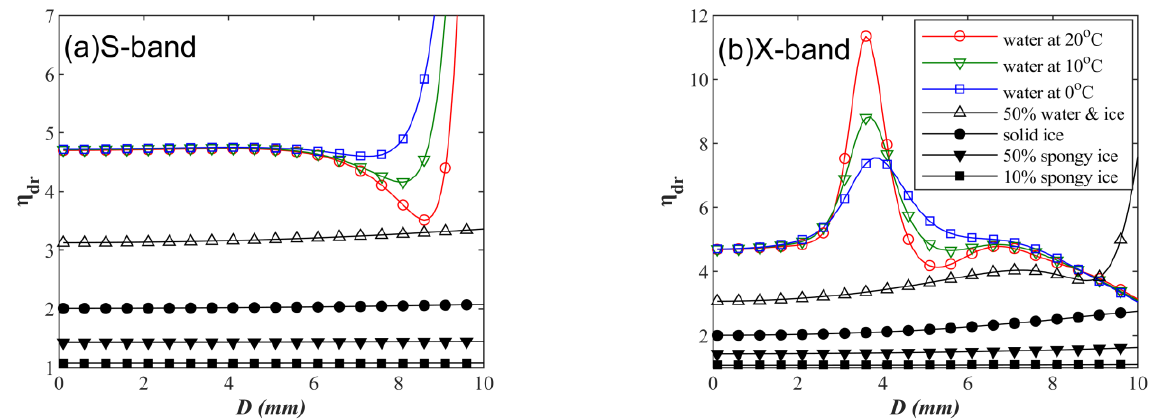
Figure 2. Variation of η dr with the spherical equivalent diameter D for a single ellipsoid water particle with an axial ratio r = 2 under different phase conditions. ( a ): S-band, ( b ): X-band. η dr represents the Z dr of a single particle.